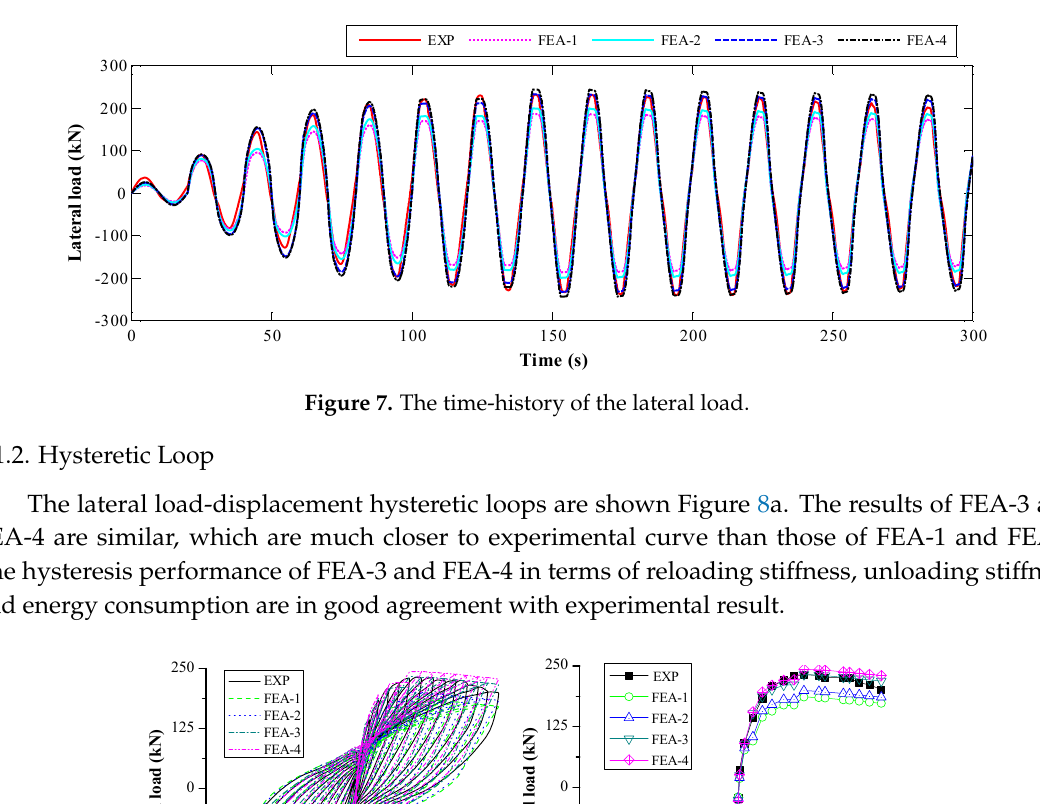
Figure 7. The time-history of the lateral load.